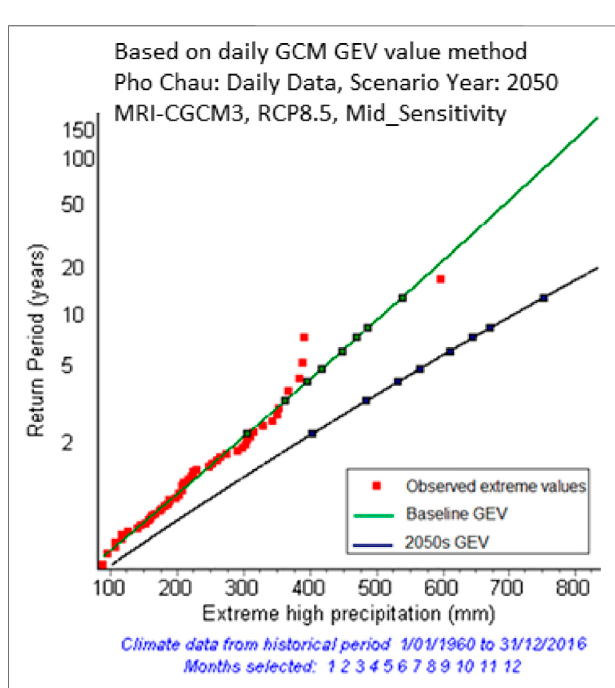
FIGURE 7 | Extreme precipitation under the baseline period and in the